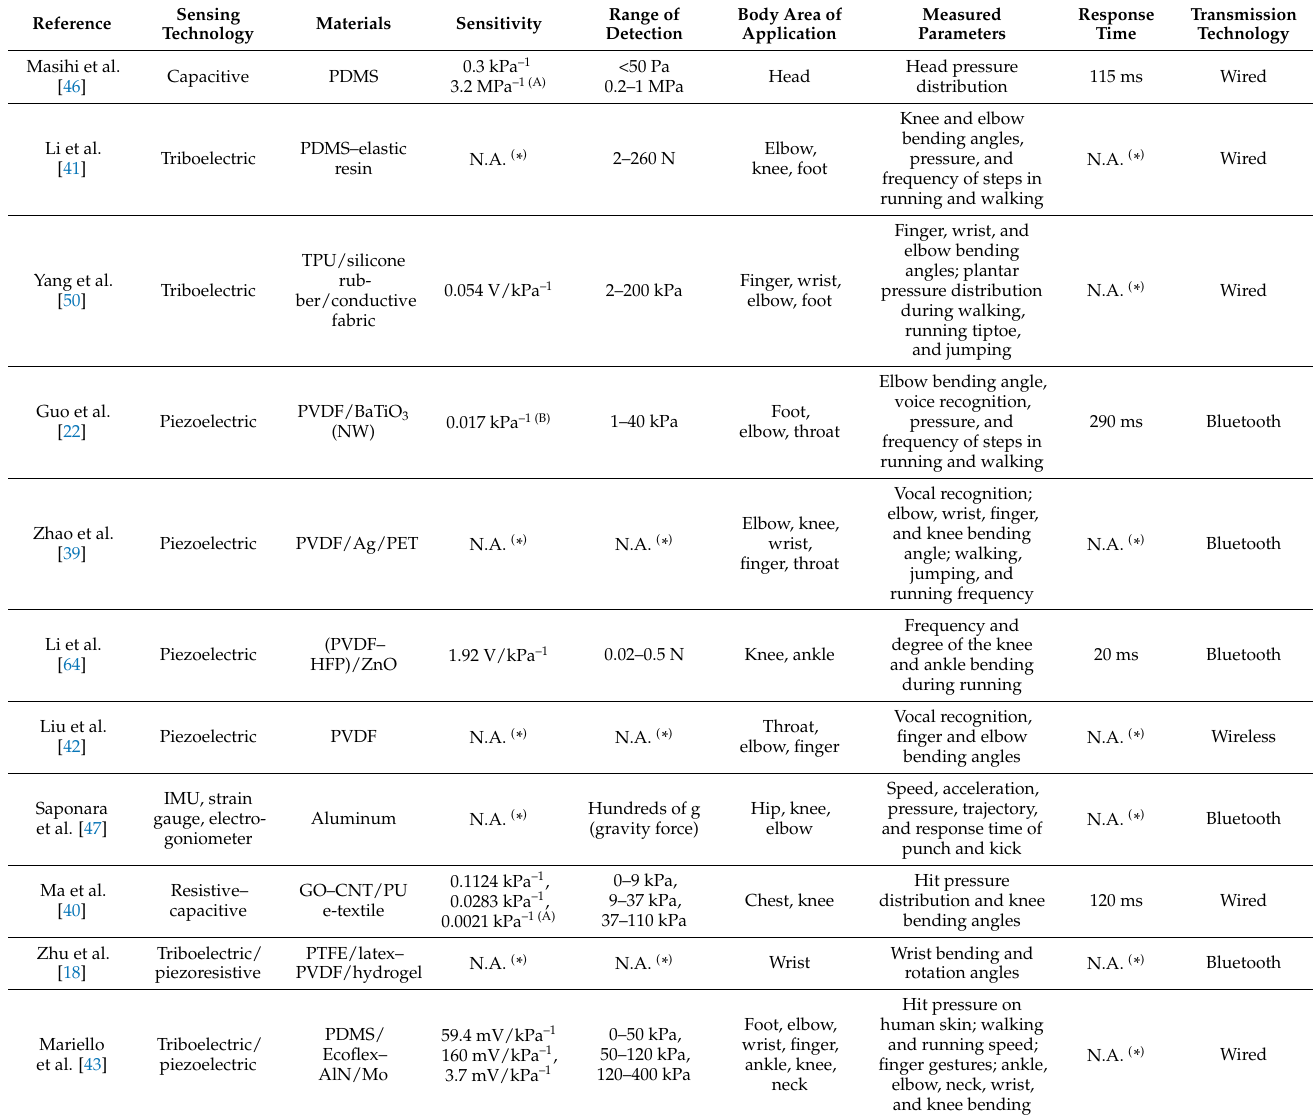
Table 5. Specification comparison of analyzed sports activity monitoring